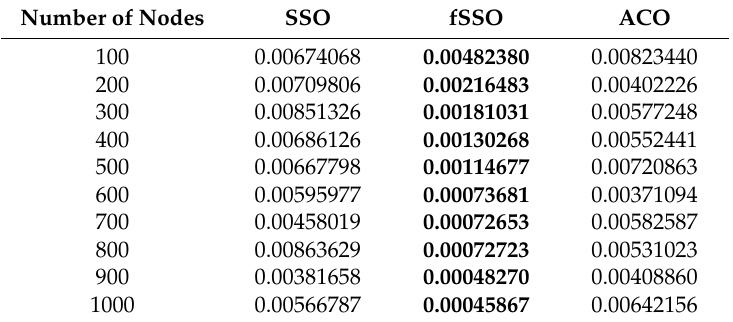
Table 14. Average of fitness values of fSSO compared with SSO and ACO for ten